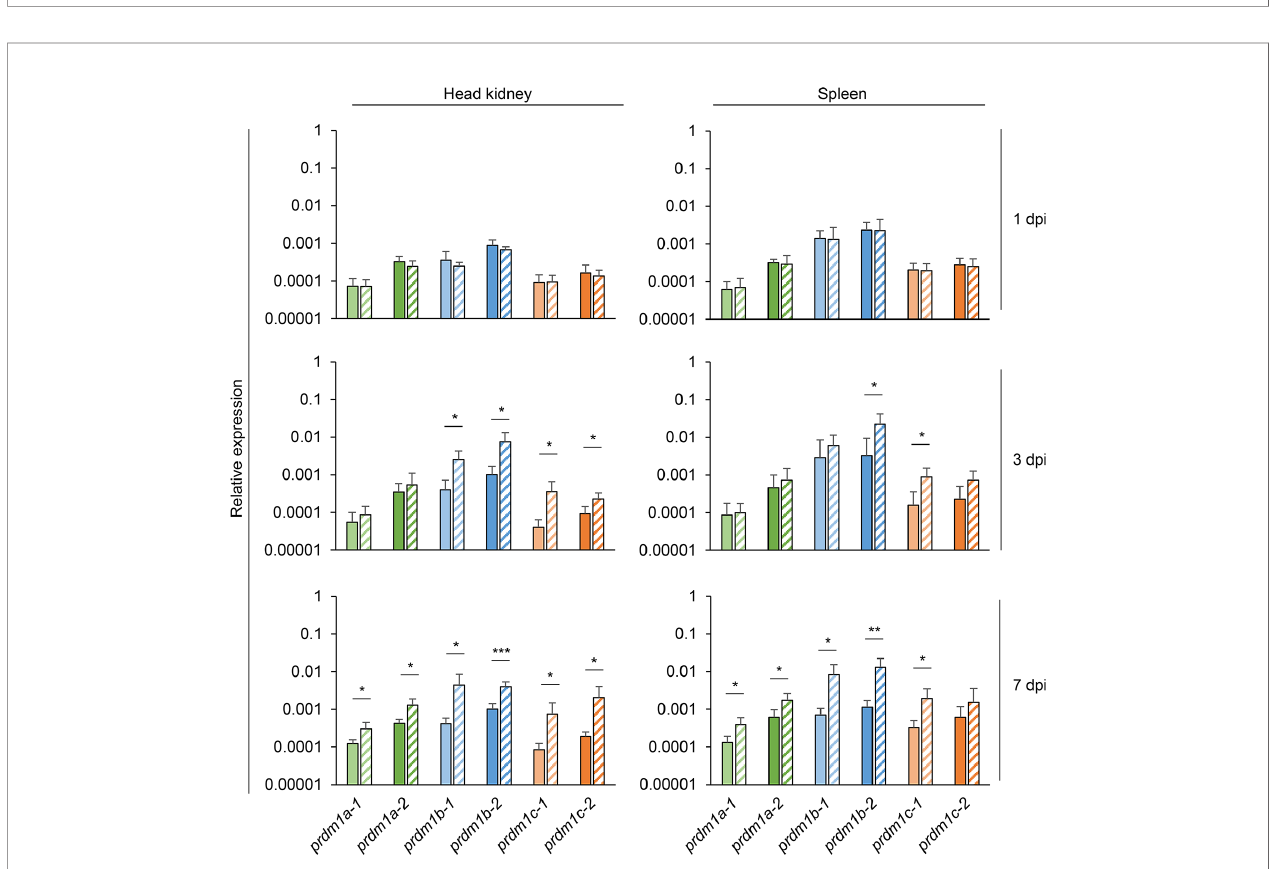
FIGURE 7 | Transcriptional patterns of O. mykiss prdm1 genes in head kidney and spleen during viral infection. The levels of transcription of the different prdm1 genes were analyzed in the head kidney and spleen in fi sh infected with VHSV by intraperitoneal injection or mock-infected fi sh at days 1, 3, and 7 days post- infection. Gene expression data was normalized against the endogenous control ef-1 a and is shown as relative expression levels (means + SD; n = 6). Asterisks indicate signi fi cant differences between transcription levels in VHSV-infected fi sh and control fi sh (* p < 0.05, ** p < 0.01, and *** p < 0.005).